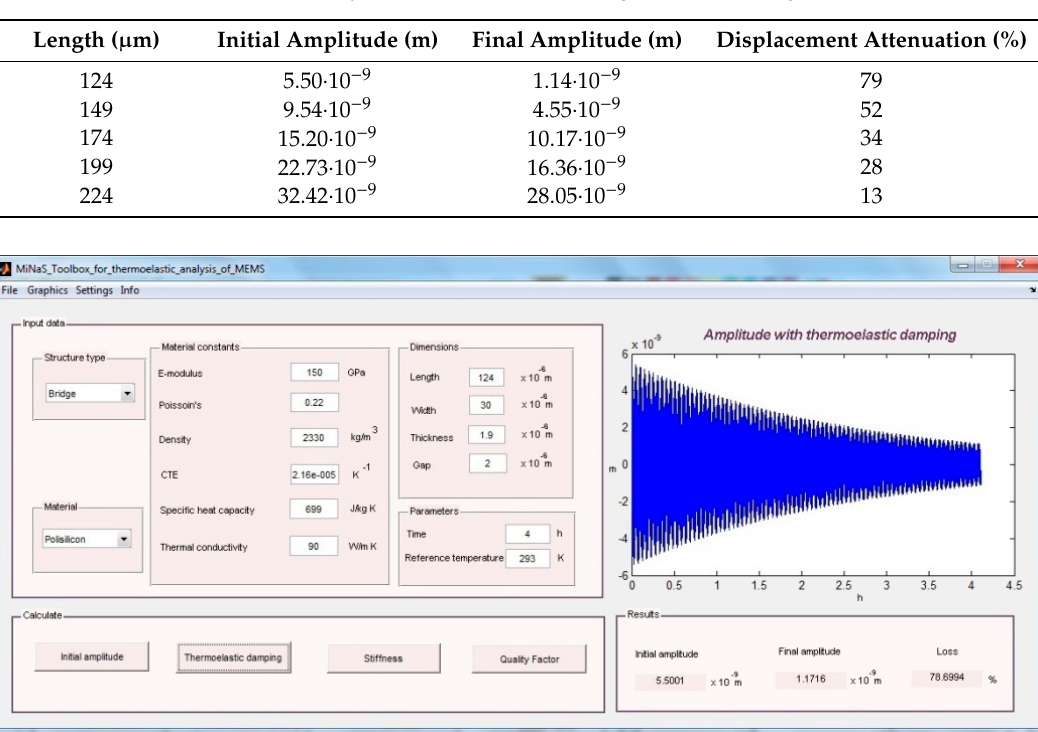
Table 3. Analytical results for the investigated micro-bridges.